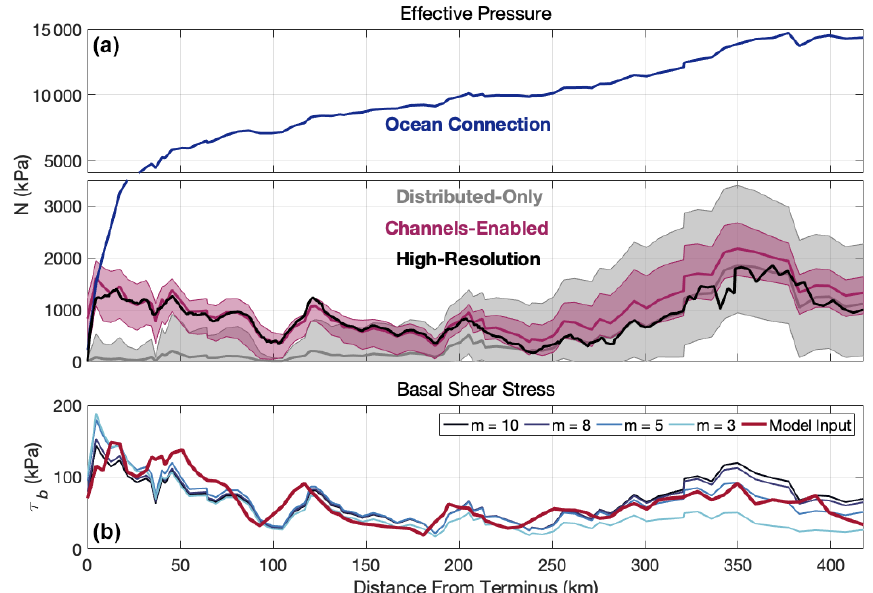
Figure 8. (a) The range and mean (solid line) of effective pressures along the center-line transect in Fig. 7a for all data-compatible FSS, channel-enabled runs (magenta), and all distributed-only runs above 90% flotation (gray). The black line depicts transect effective pressures from the high-resolution run. Shown in blue is the calculated effective pressure if assuming a perfect hydrostatic connection with the ocean. Note the different y -axis scales in (a) . (b) Basal shear stress used as input in our model (red) plotted with reconstructed basal shear stress using a Budd-style friction law (blue). Blue hues represent different exponents used in the friction law. All lines follow the same center-line transect as in (a)